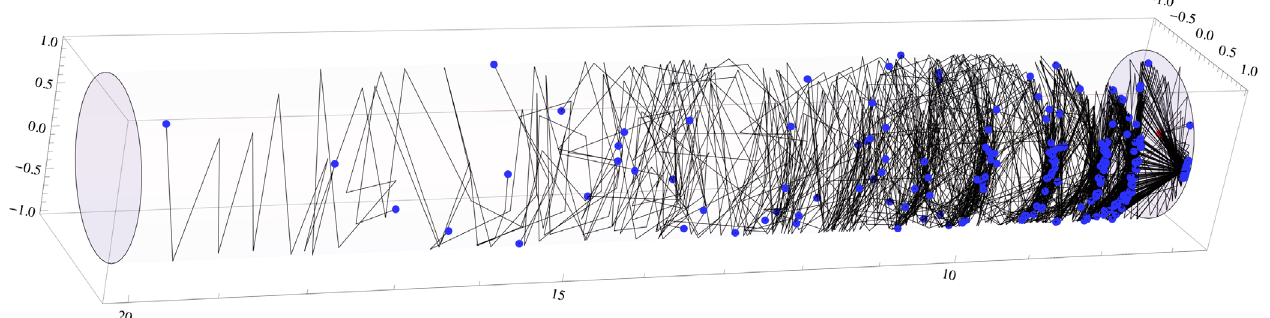
FIG. 12. Photon trajectories from a dipole in three dimensions. The photon source is on the right. For purposes of illustration, the transverse geometry has been distorted from an ellipse to a circle, and the longitudinal dimension has been shrunk by a factor of 10. Black lines are trajectories, and blue dots are photon absorption sites. Photons generated by the beam propagate downstream (to the left in the figure) and strike the vacuum chamber. Some are absorbed, but most scatter and strike the vacuum chamber further downstream. The absorption site locations tend to be clumped in several clusters (at the location of downstream dipoles), with decreasing intensity as we get further from the source.